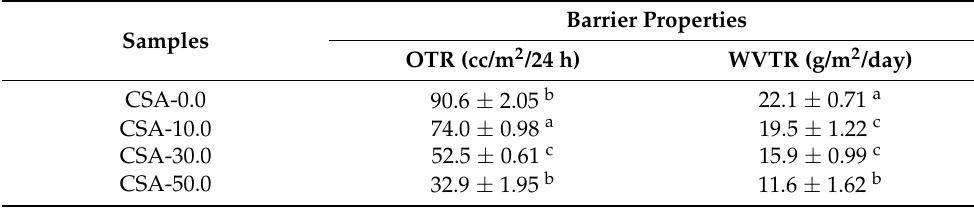
Table 2. OTR and WVTR properties of chitosan and chitosan/almond gum composites.